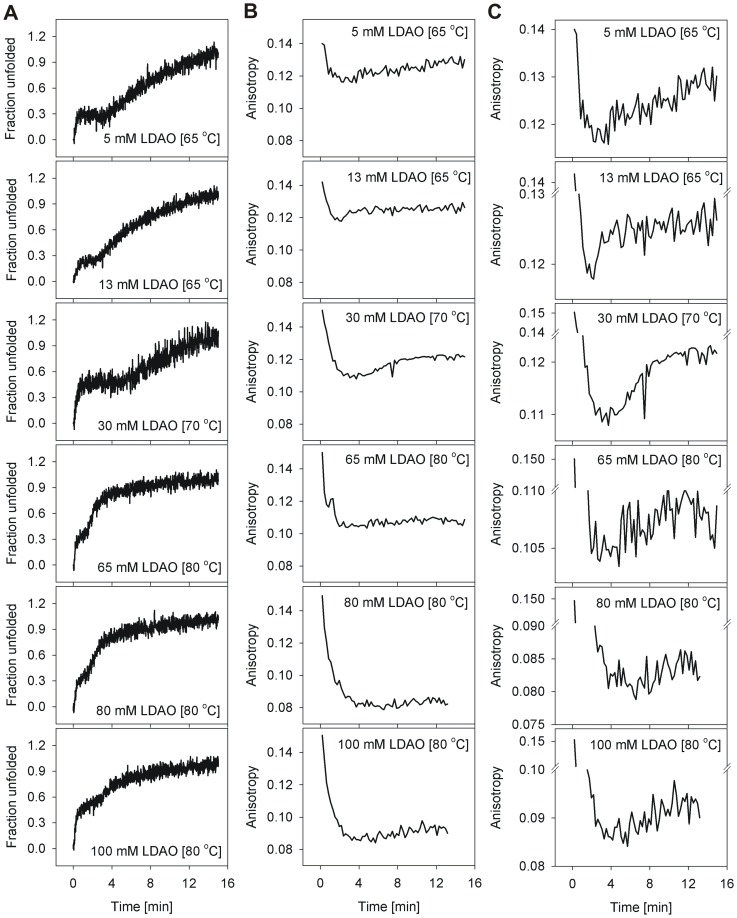
Isothermal unfolding kinetics of hVDAC-2 C0 monitored by comparing loss in ME215 with change in anisotropy.Shown are representative graphs illustrating the (A) loss in ME215 (converted to fraction unfolded) and (B and C) Trp fluorescence anisotropy. The temperatures at which two transitions were obtained in CD experiment for the different LDAO concentrations were used to monitor the change in tryptophan anisotropy, to understand the origin of the two transitions of C0. As seen in the case of WT, the first CD transition provides a concomitant rapid decrease in anisotropy. However, unlike WT, anisotropy values of aggregated C0 are lower. Furthermore, anisotropy of C0 decreases with increase in temperature (established by independent experiments, data not shown). The increase in anisotropy with time, corresponding to the second ME215 transition, although present, is therefore not as prominent in C0 as its WT counterpart. This second transition is therefore highlighted separately in (C). We speculate that this difference in anisotropy values arises from the varied affinity of both WT and C0 to LDAO. While aggregation is faster in C0 (see Figure 4), the corresponding change in anisotropy is marginal, since this construct has little affinity for LDAO molecules. Unfolded WT protein is presumably bound to sufficient LDAO that results in a greater change in anisotropy from 0.12 to 0.16.